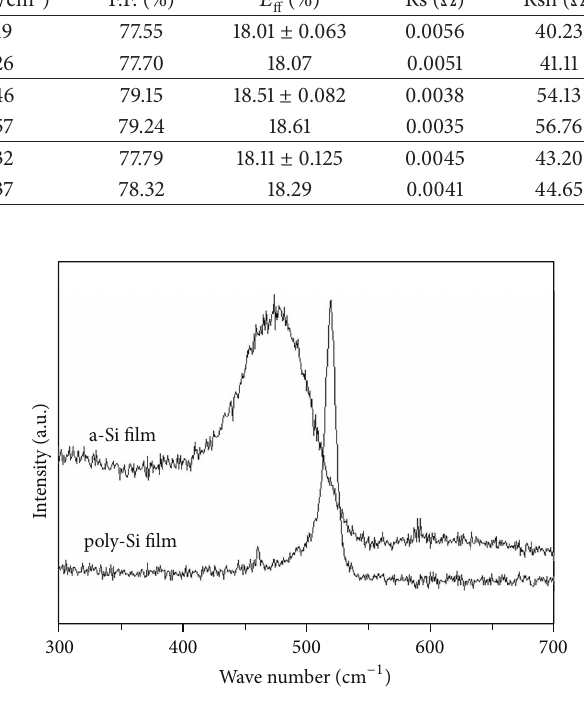
Figure 3: Raman spectra of silicon films with and without going through a high-temperature process,